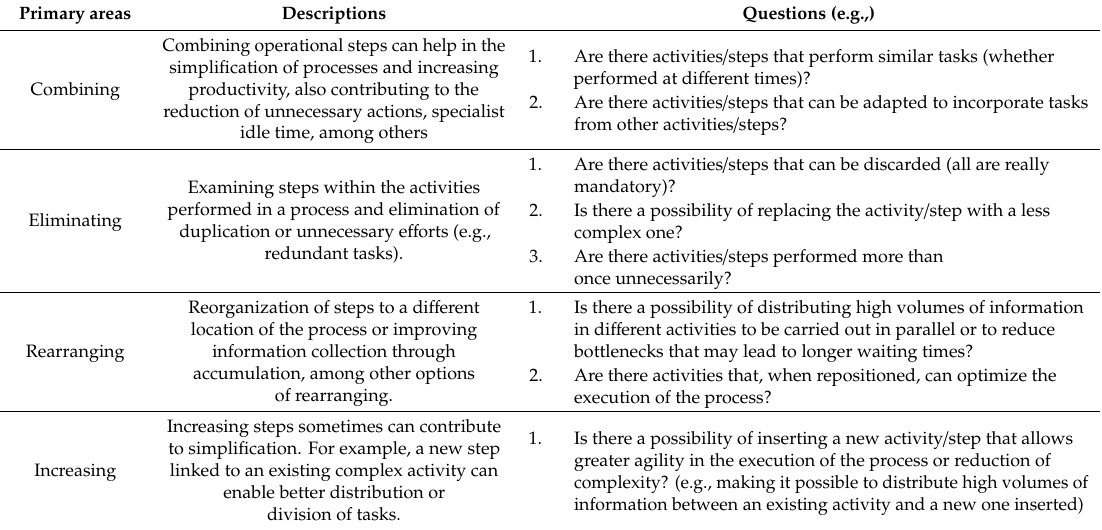
Table 7. Primary areas for simplification and adopted questions examples.